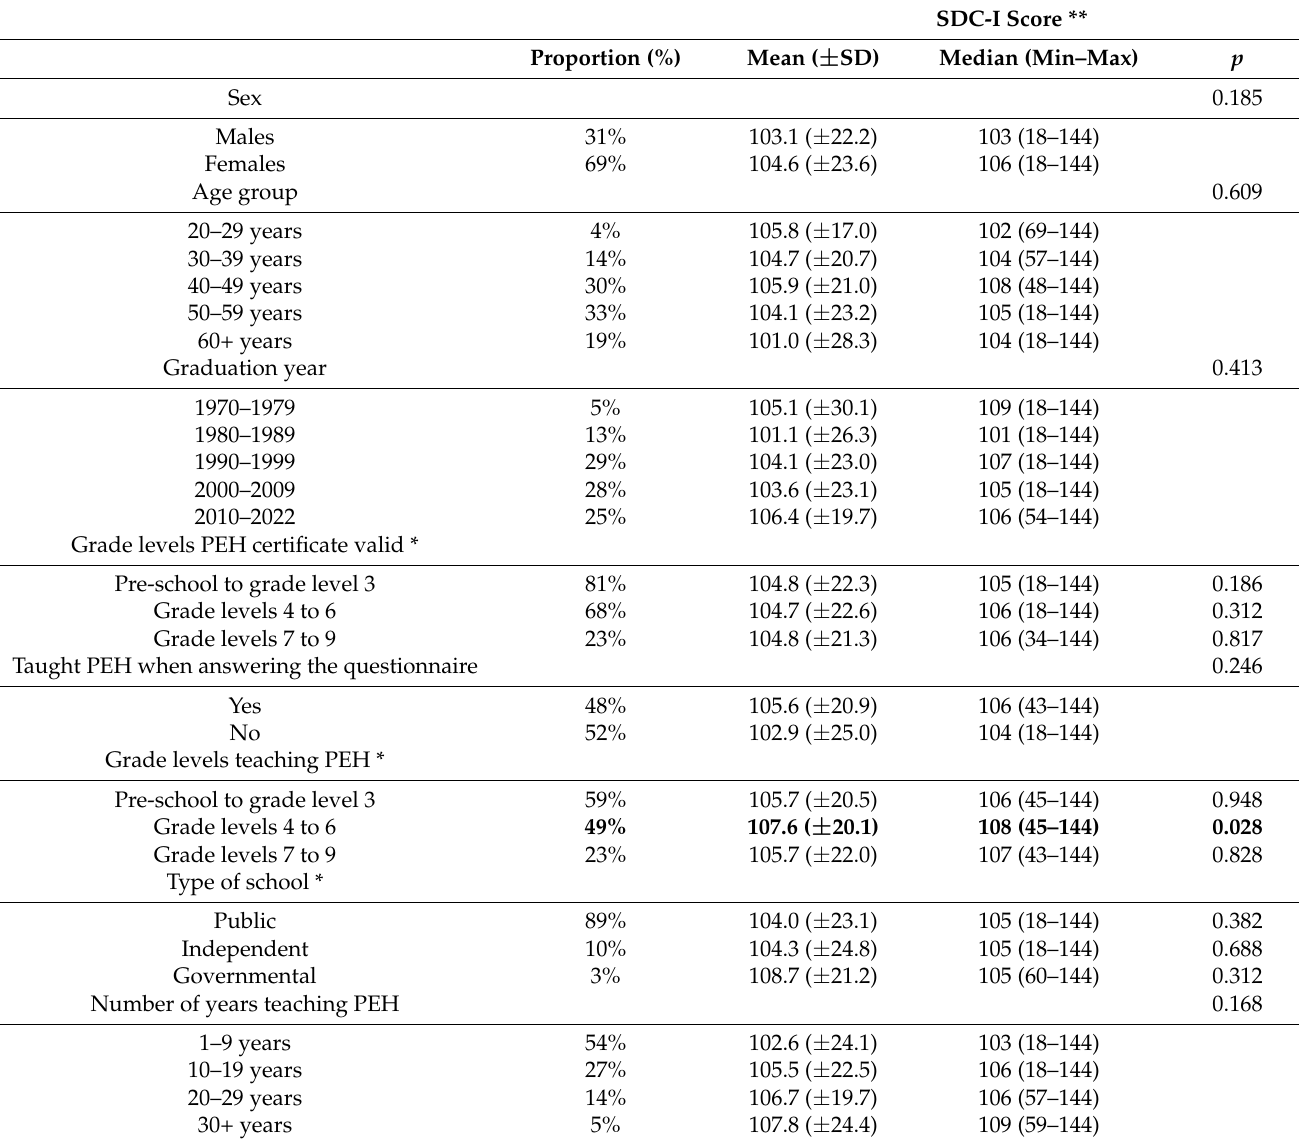
Table 1. Study participant characteristics and SDC-I score across different groups of participants (total sample: n =